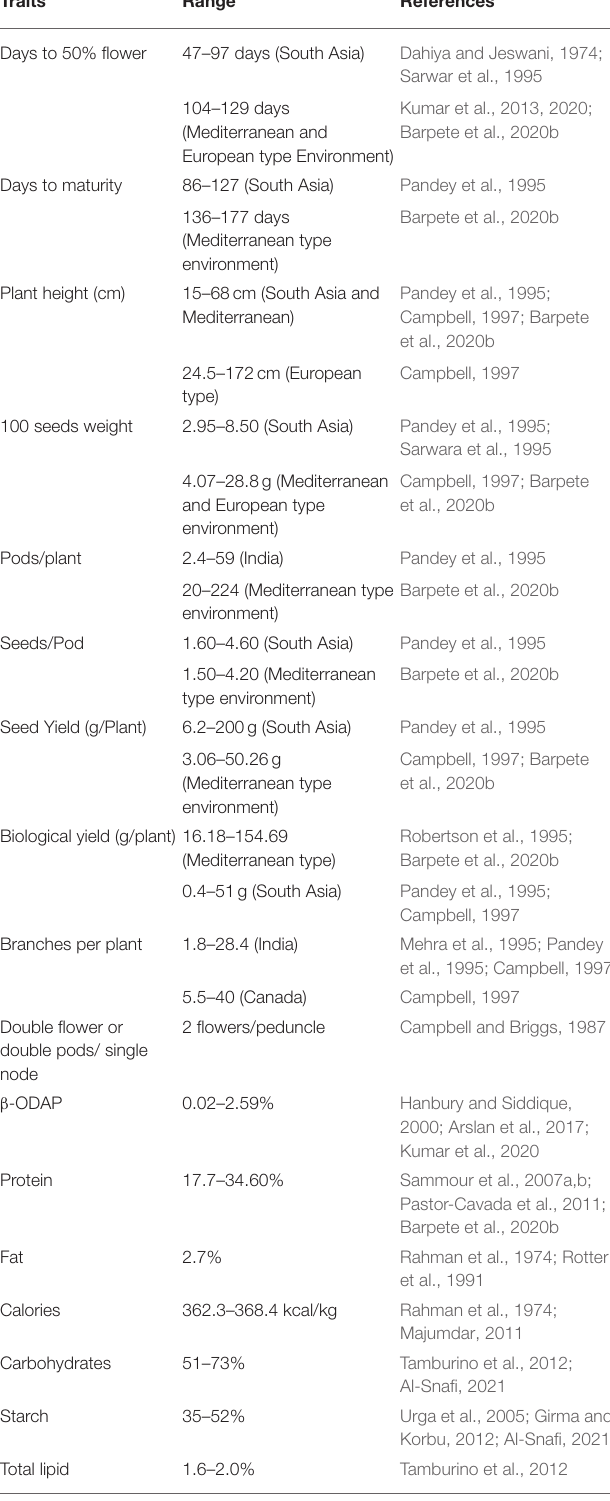
TABLE 1 | Genetic variation on important agronomic and seed quality traits in grass pea.